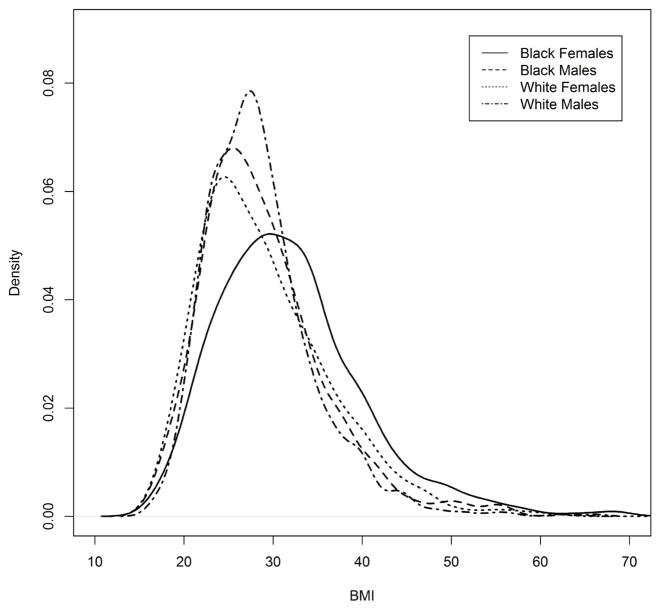
Kernel density estimates of BMI for adult black females, black males, white females, and white males between ages 20 and 79.